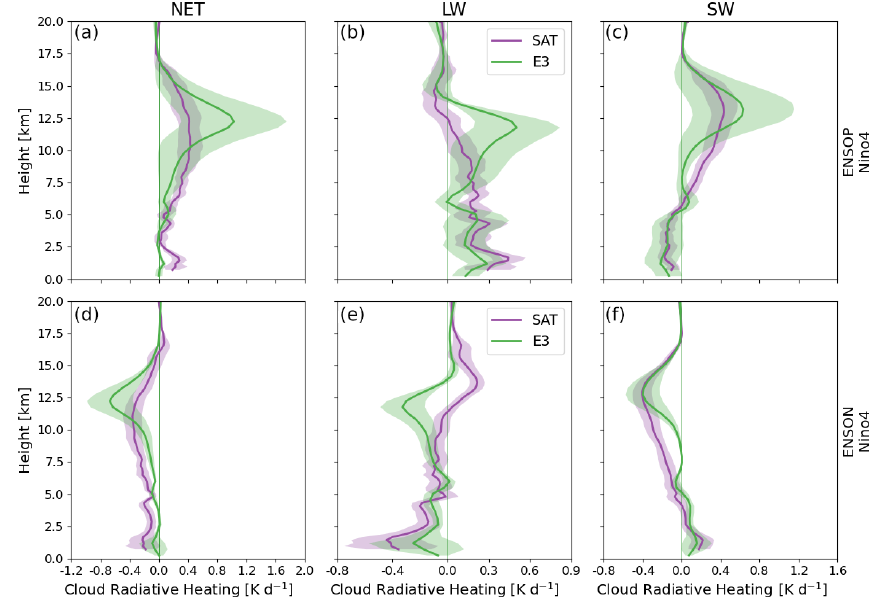
Figure 10. Vertical cloud radiative heating anomalies for EC-Earth3 (E3) and CloudSat/CALIPSO observations (SAT) averaged over the Niño4 region for both ENSOP (a–c) and ENSON (d–f) . Column 1: net (SW + LW; NET) heating, column 2: longwave (LW) heating and column 3: shortwave (SW) heating. Shaded areas show ± 1 σ spread based on monthly mean